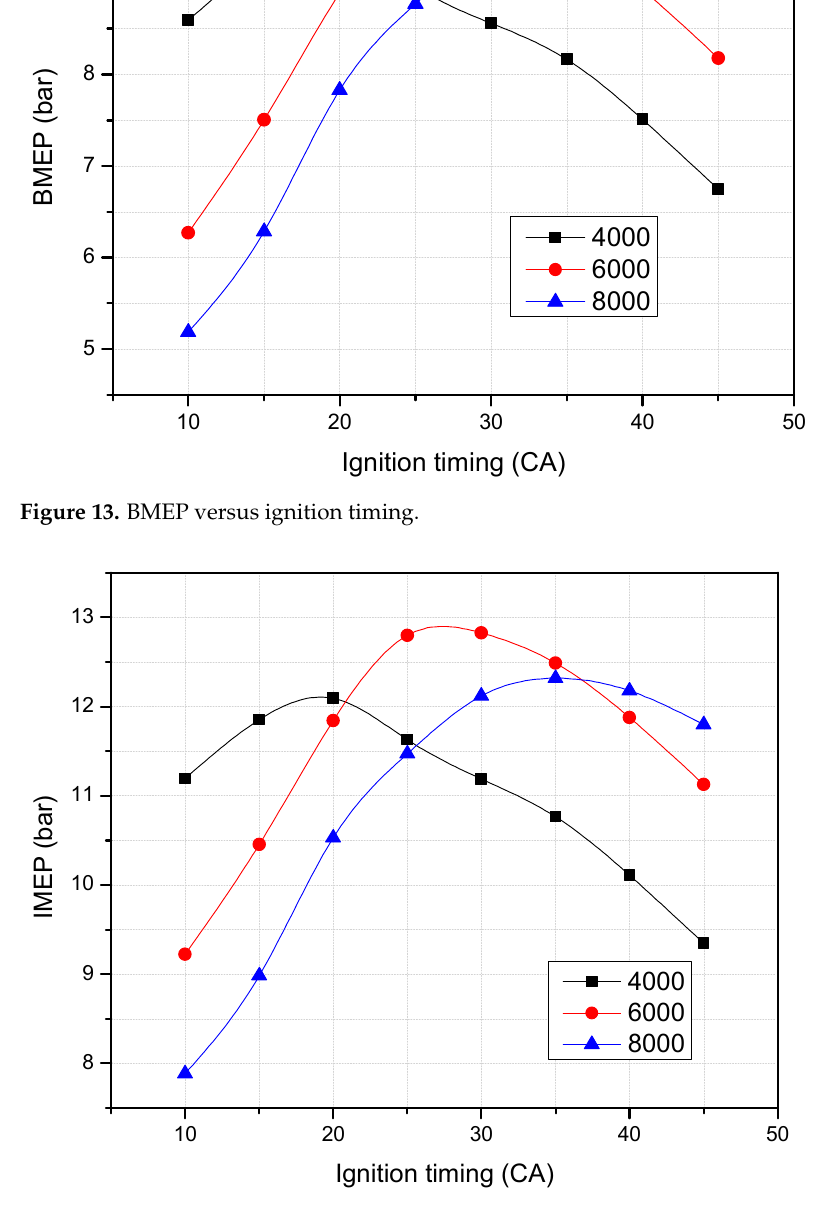
Figure 14. IMEP versus ignition